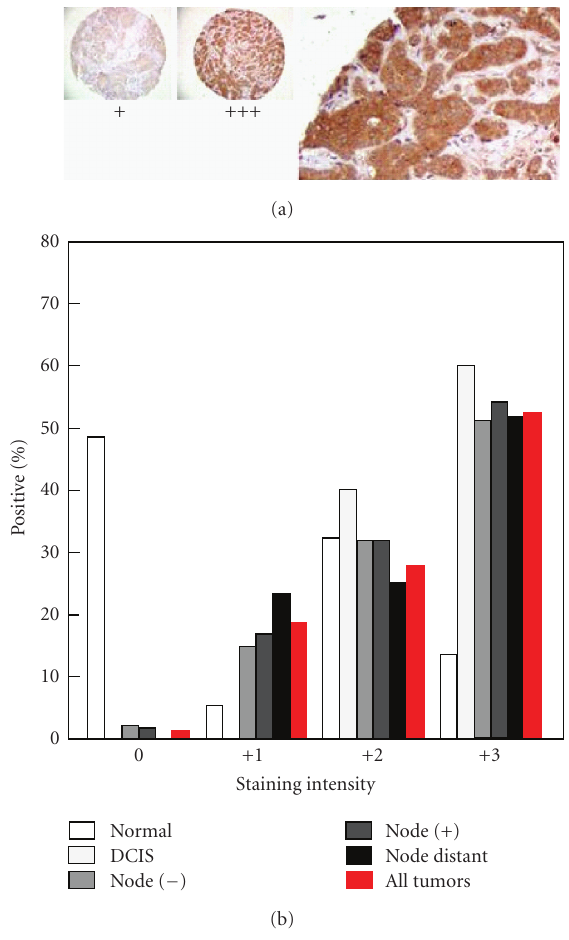
Figure 2: PPAR δ expression in invasive breast cancer. Repre- sentative samples from a tissue microarray analysis of invasive breast cancers are shown. PPAR δ staining intensity is indicated as low (+1), medium (+2) or high (+3). The magnified image shows examples of +1 and +3 staining. The bar graph depicts the percentage of samples expressing PPAR δ in DCIS, node (+), node ( − ) and node distant